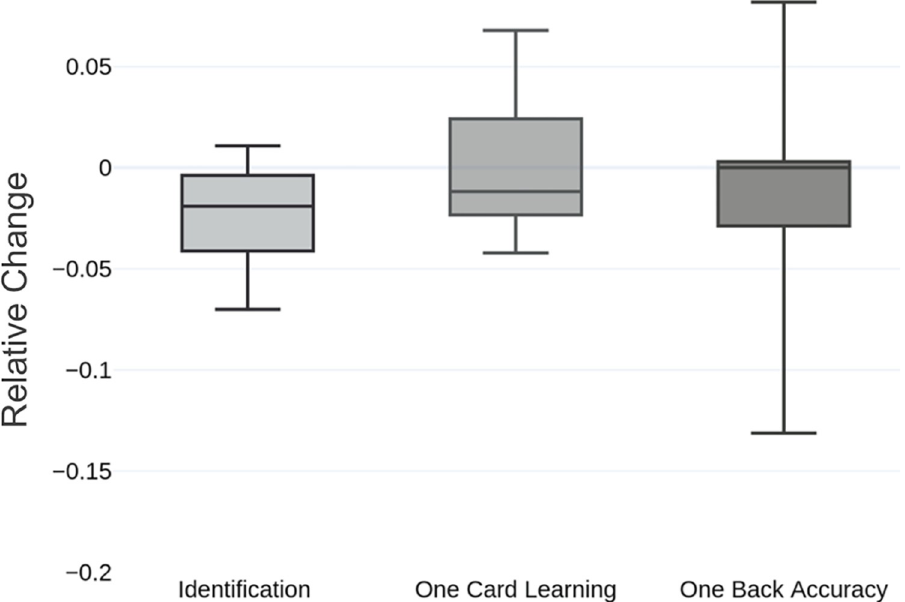
Fig 3. CogState test scores over 12 weeks of treatment. Average relative changes of CogState test scores over course of 12-week treatment. The decreased average relative change indicates that there was a decrease in test performance across the tested cohort (n = 8 at each time